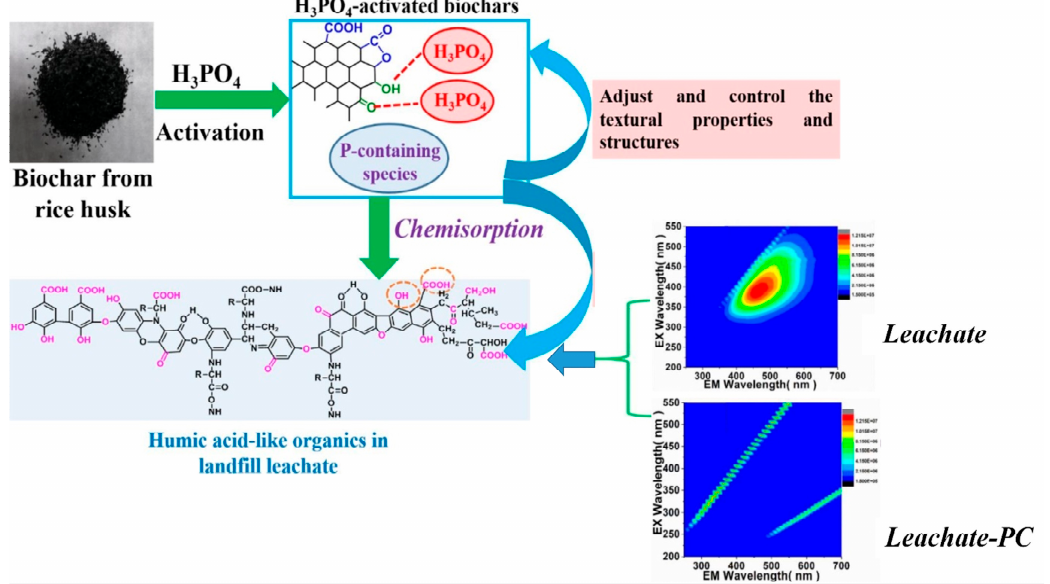
Figure 6. Treatment mechanism through adsorption from landfill leachate by activated biochar